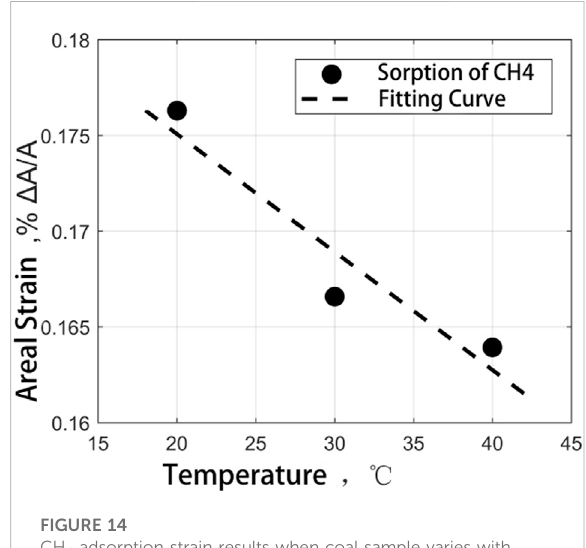
FIGURE 14 CH 4 adsorption strain results when coal sample varies with experimental